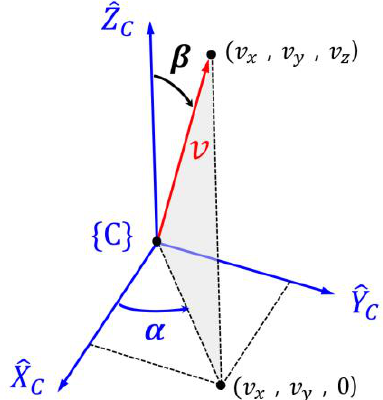
𝑌′̂ 𝑋̂ 𝐶 ; ( b ) rotation around 𝑆 ; ( c ) rotation around 𝑆 .